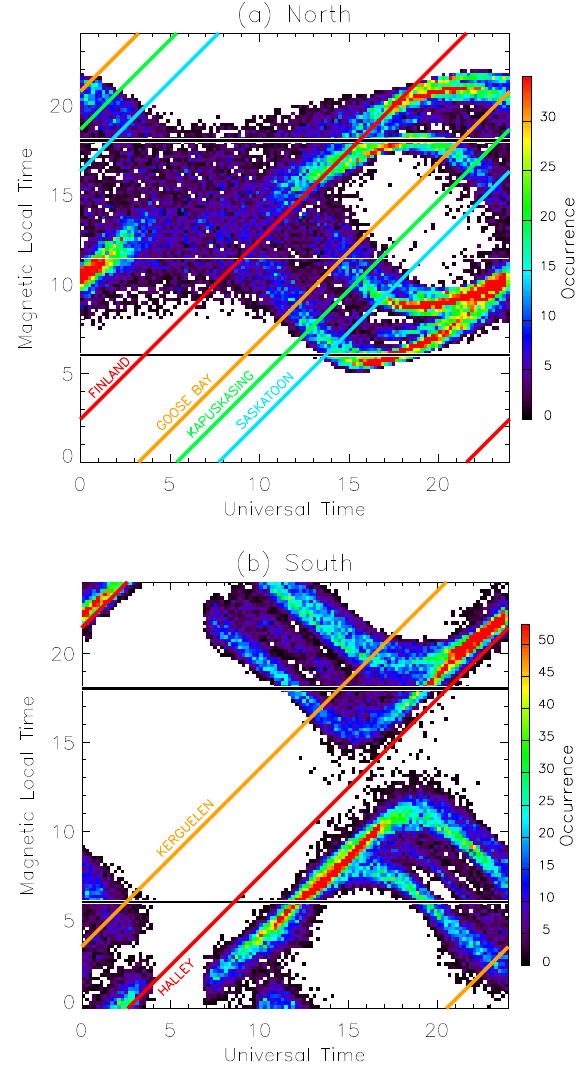
Fig. 3. The UT-MLT coverage of boundaries (both SWB and OCB) in ( a ) the Northern Hemisphere, and ( b ) the Southern Hemisphere. The coloured diagonal lines show the coverage of meridional beams from the SuperDARN radars used and hence the coverage of SWBs. The shaded region represents the coverage of OCB proxies from the five DMSP spacecraft (separated into 0.2 by 0.2h sectors) colour- coded by occurrence. The horizontal black lines represent the loca- tion of the transition from nightside (b6) to dayside (doc) boundary